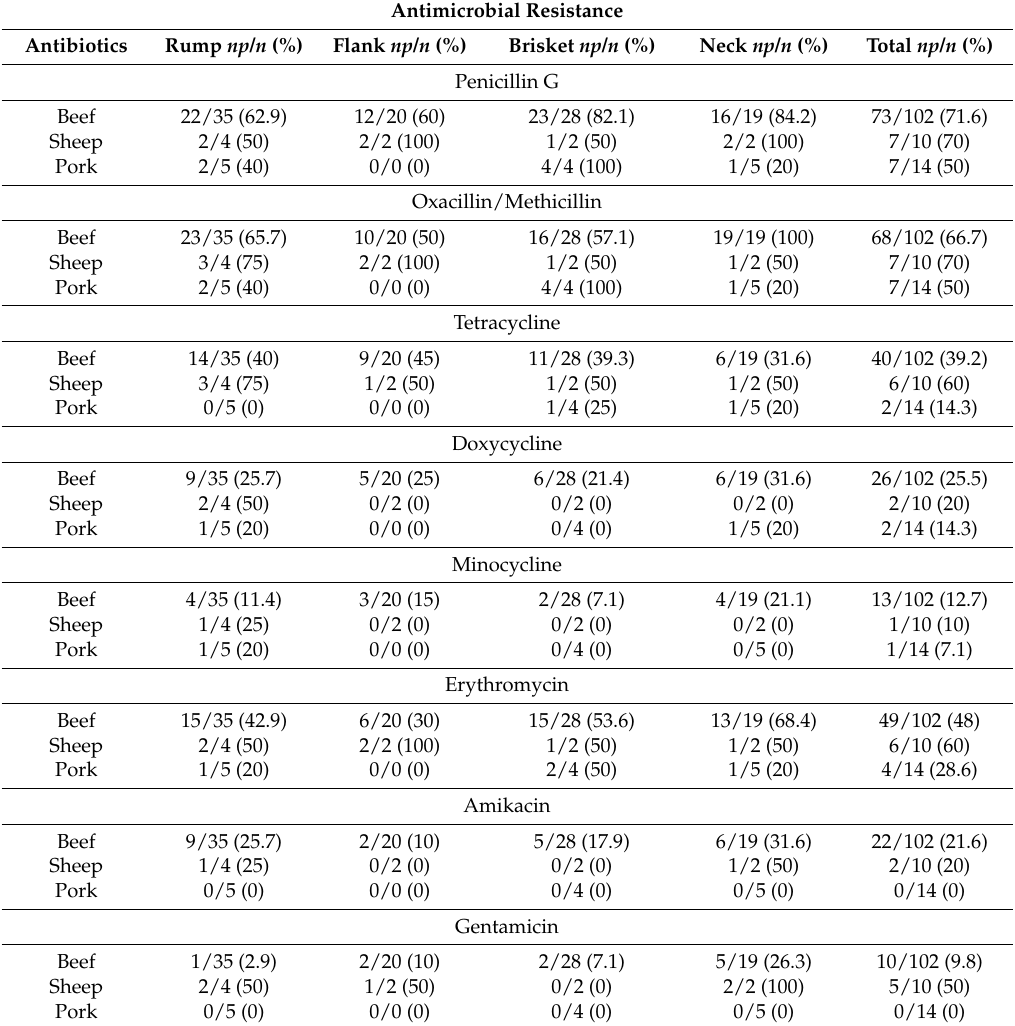
Table 2. Antibiotic resistance of Staphylococcus aureus isolates in beef, sheep and pork samples against 14 different